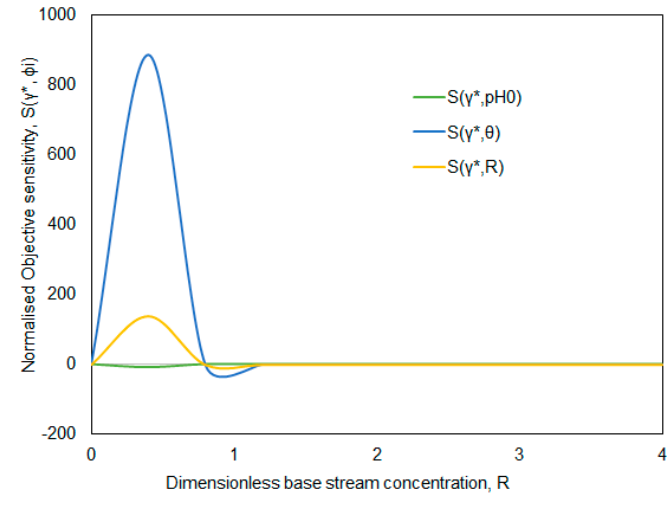
Figure 4. Normalized objective sensitivities S( γ *, ϕ i) as a function of base concentration R.